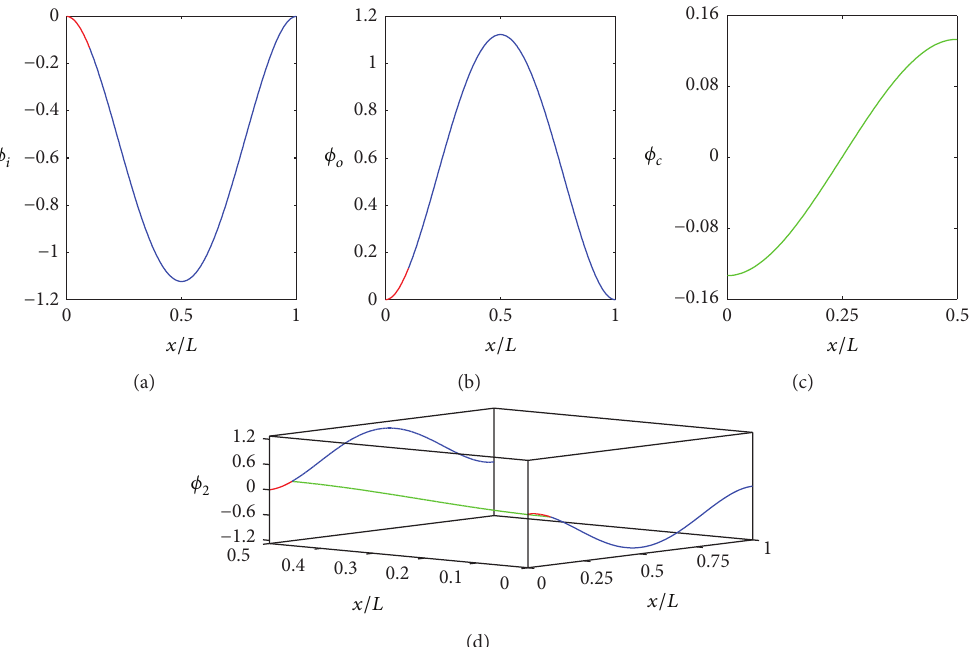
Figure 3: Second mode shape of the filter: (a) input, (b) output, (c) coupling beams, and (d) combination of (a), (b), and (c).